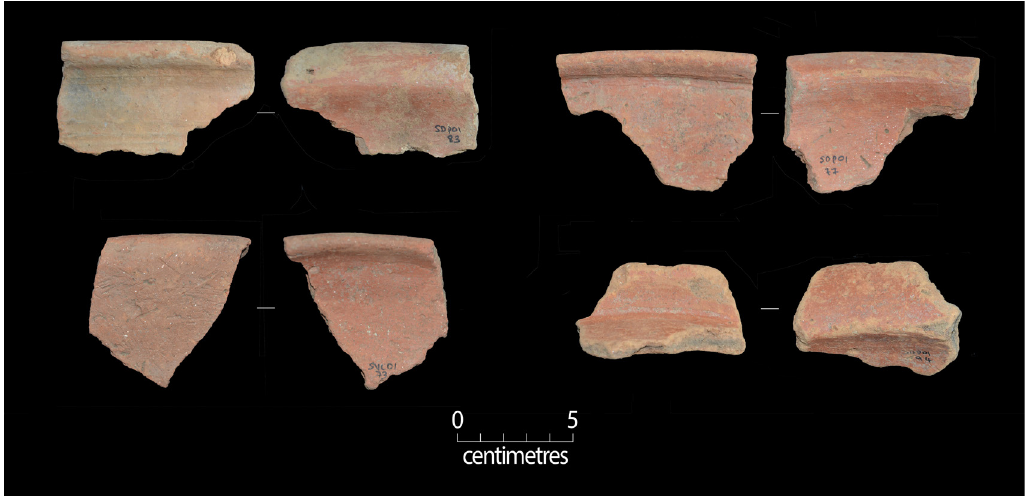
Figure 33: External and internal surfaces of four Class 10 variant 4